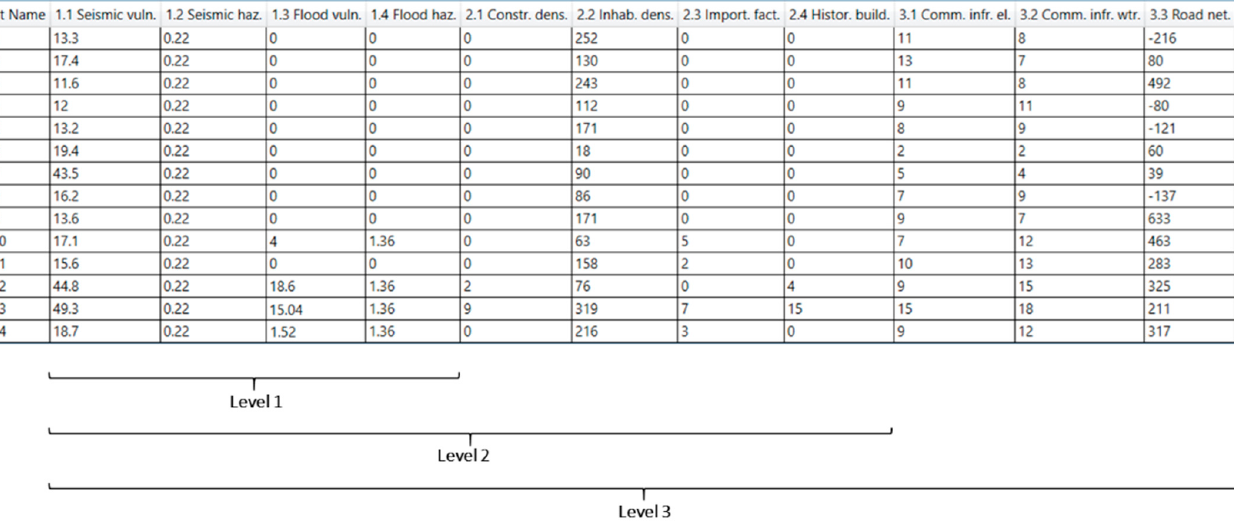
Figure 14. Input matrix for combined seismic-flood risk (Scenario S-F) multi-criteria analysis with criteria evaluation for all three levels.